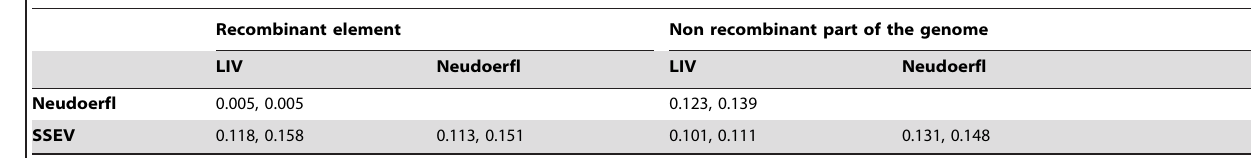
Table 2. Genetic distance between LIV, Neudoerfl and SSEV.